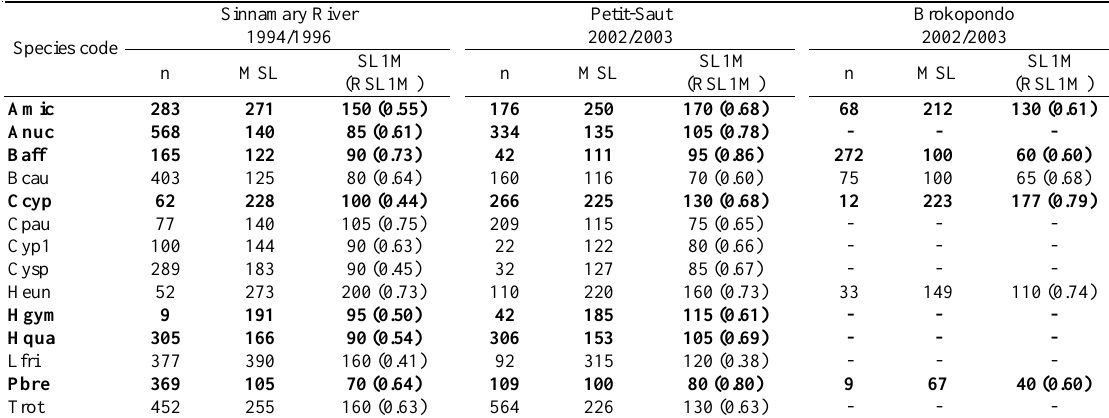
Table 2. Maximum standard length (MSL), size at first maturation (SL1M) and relative size at first maturation (RSL1M - between brackets) in the different sampling sites and periods. “-” = not present.